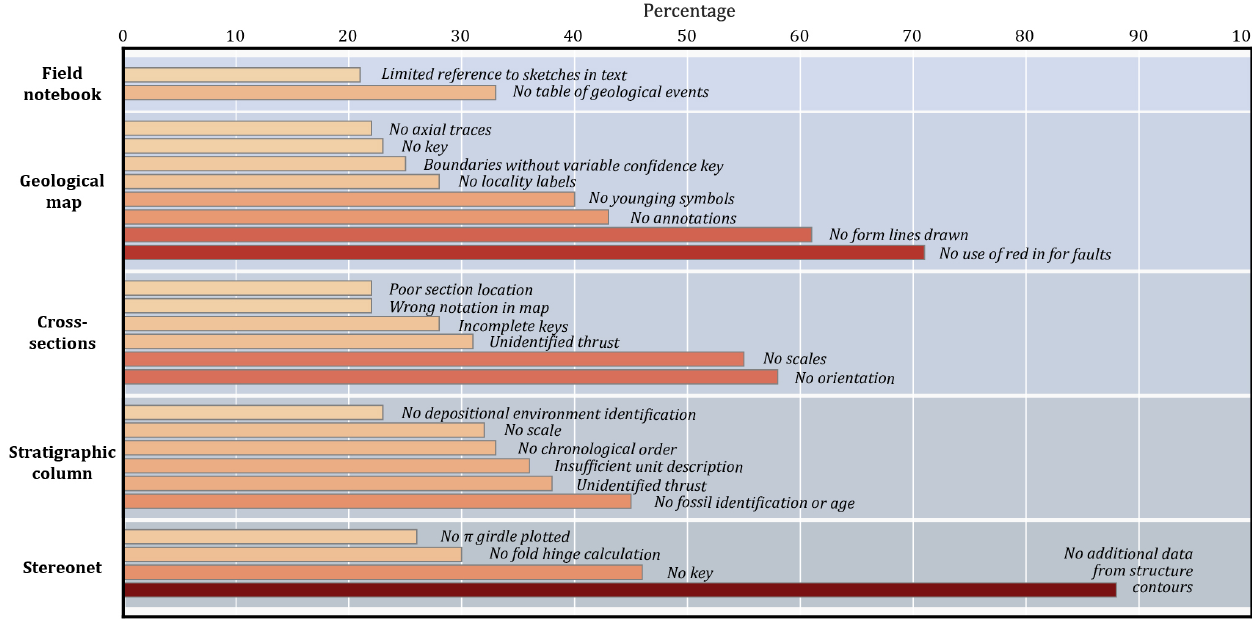
Figure 4. Most common student mistakes in the different tasks that comprise the Esla Mapping Project. Most of them could be easily rectified with a more comprehensive set of instructions and preparatory lessons. Percentage is calculated from a total number of students of